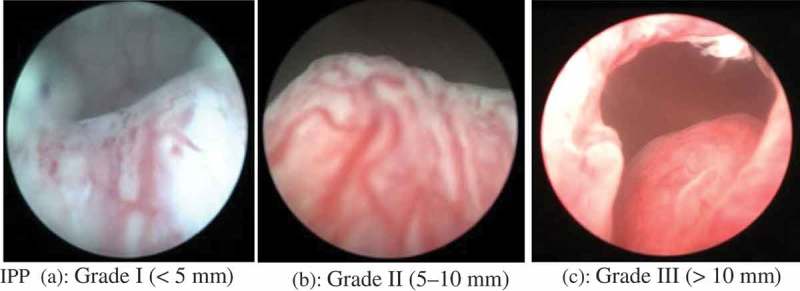
The grading system (a, b and c) for the IPP confirmed by cystoscopy. (a) IPP Grade I, <5 mm; (b) IPP Grade II, 5–10 mm; (c) IPP Grade III, >10 mm.